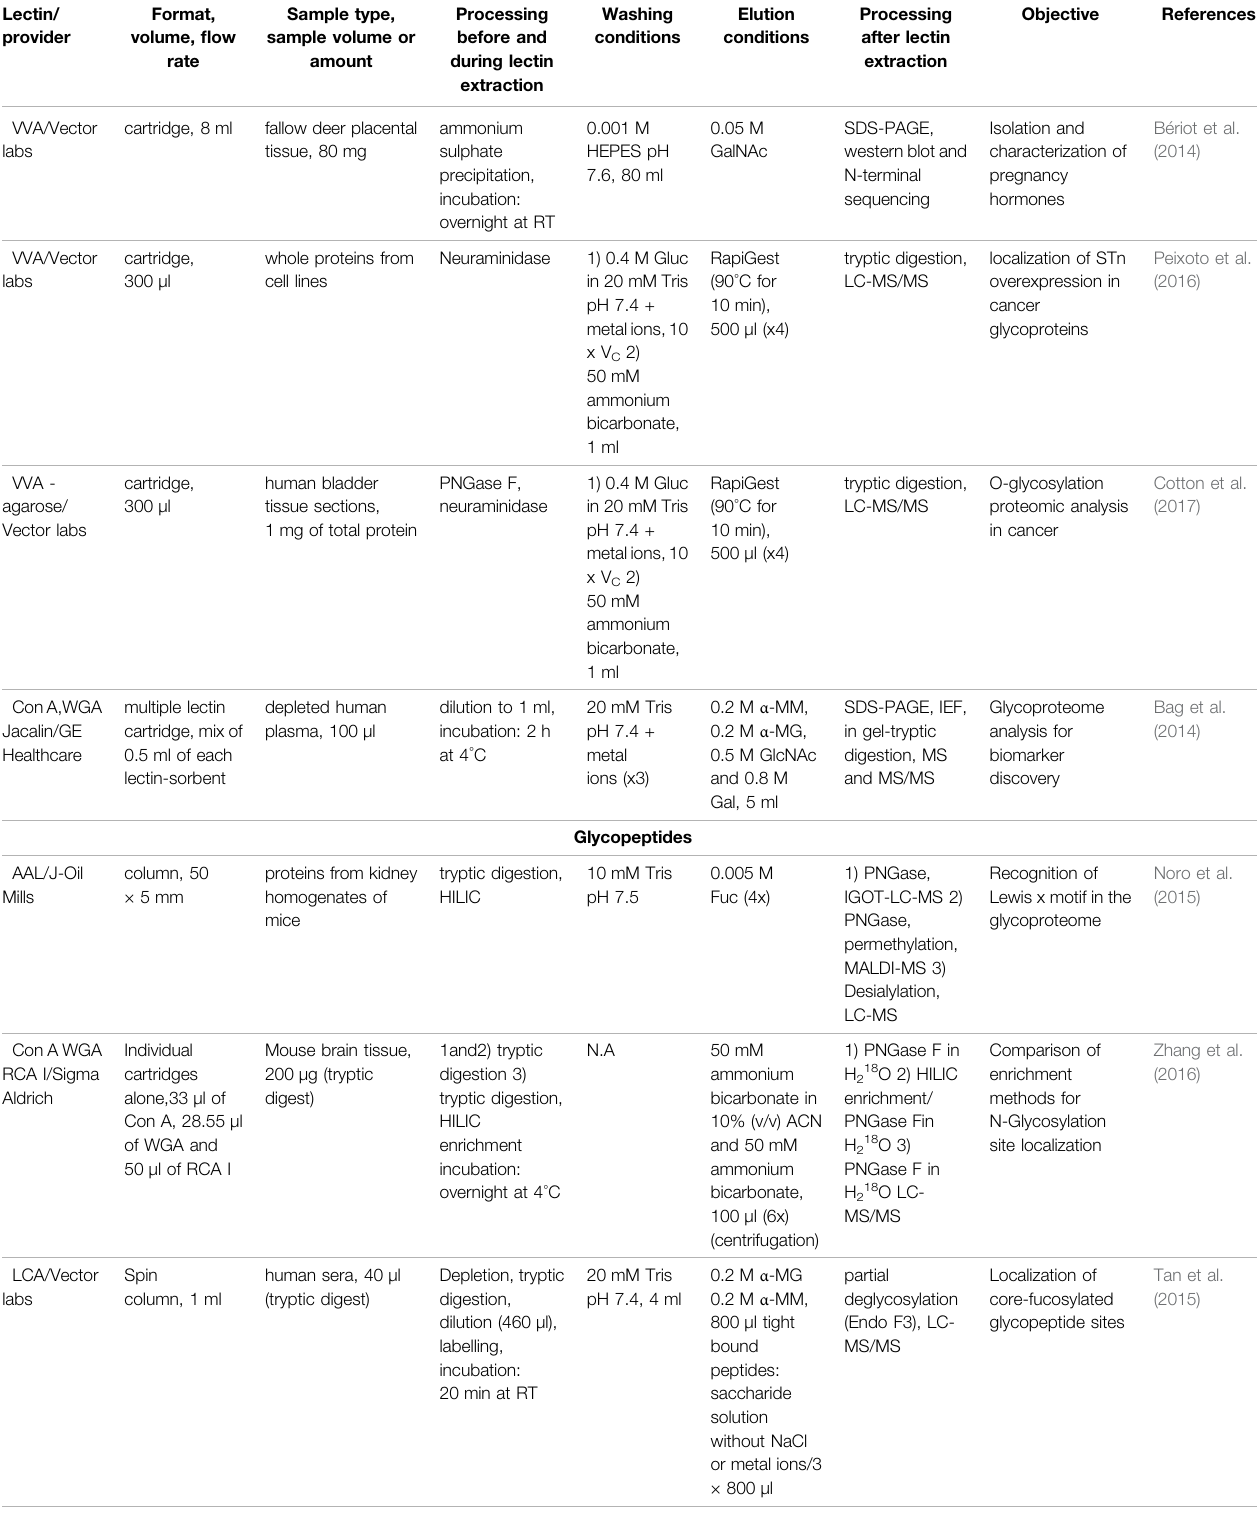
TABLE 2 | ( Continued ) Lectin solid phase extraction using commercial